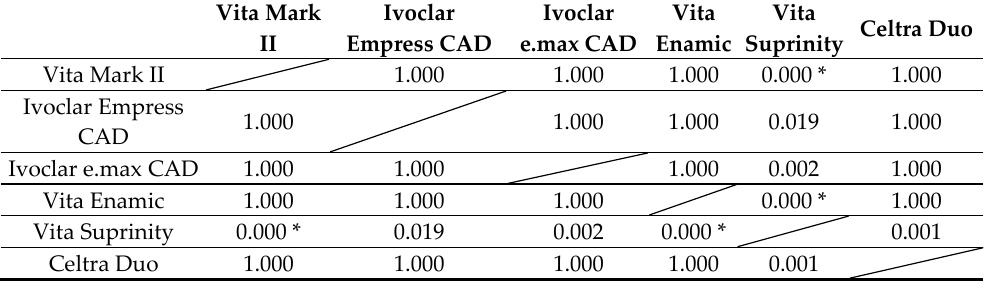
Table A11. Comparison of the different ceramics during the pull-off test: Panavia 2.0. Vita Mark II